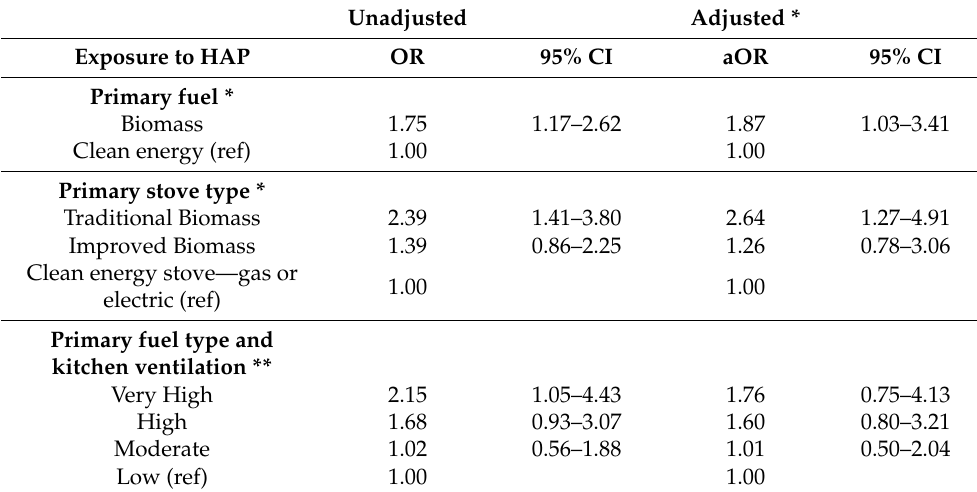
Table 4. The impact of HAP as determined by primary fuel type, stove type and cooking fuel, and ventilation during pregnancy on the small for gestational age (SGA) parameter for 445 births in rural Sri Lanka,